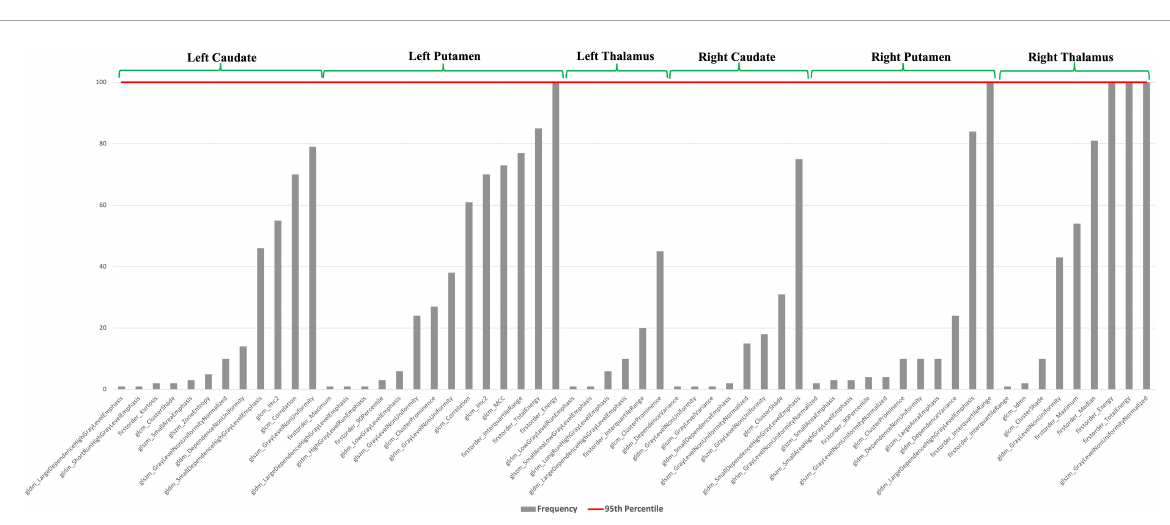
FIGURE5 Frequency of radiomics features for PD vs. HC classification. Red line defines 95th percentile beyond which we choose the most stable